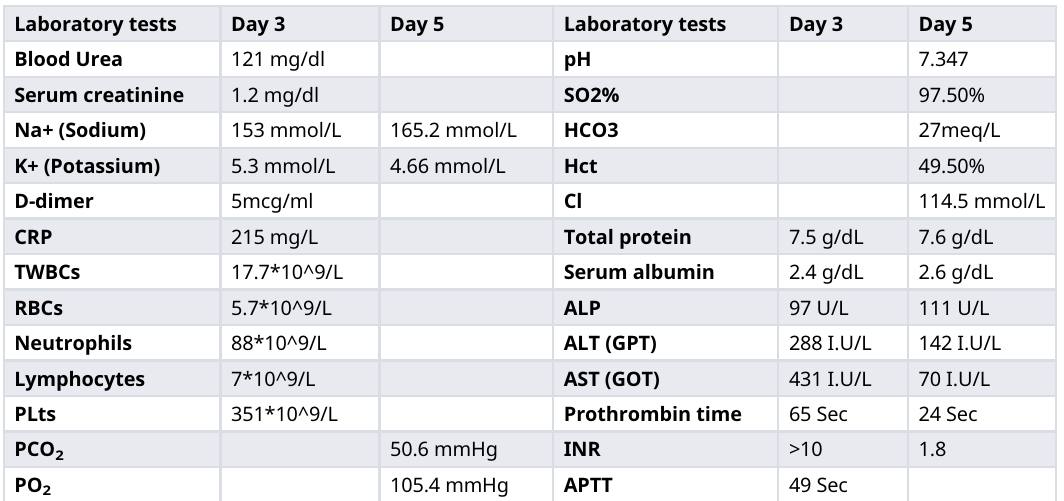
Table 3. Results of laboratory examinations of the patient (Case